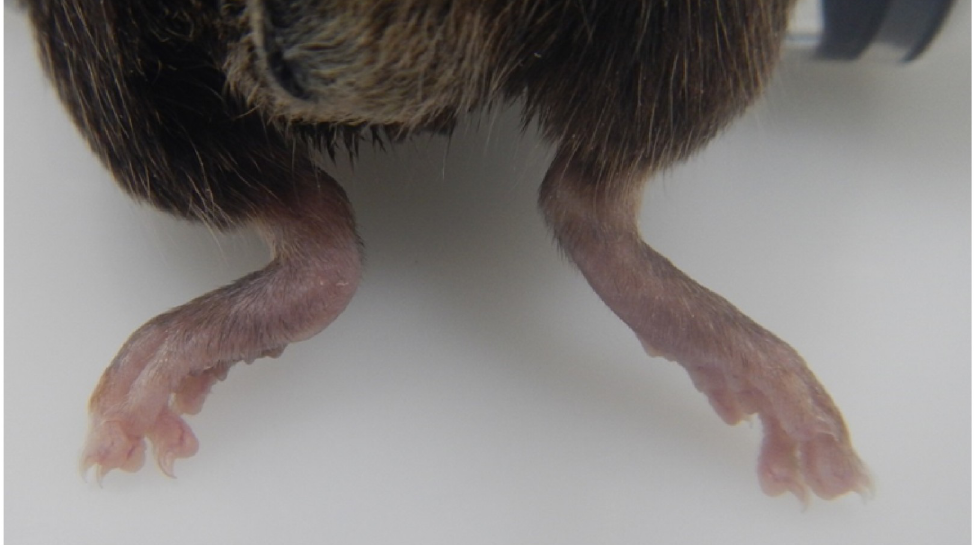
Fig 1. Dorsal view of unaffected right tarsus and rounded, swollen tarsus (reader’s